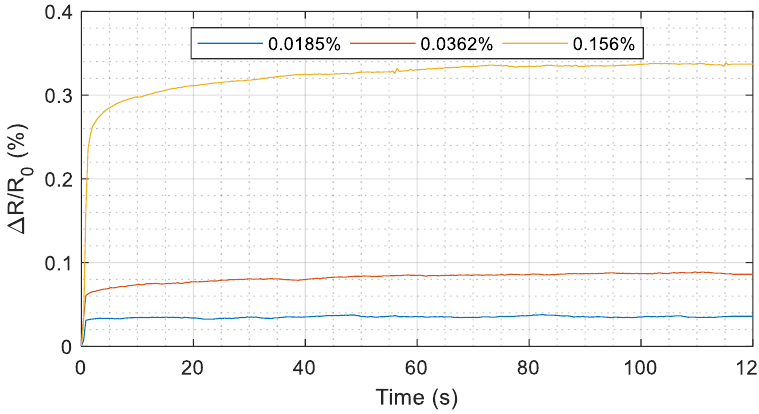
Figure 13. Resistance change with respect to the starting resistance (no external loads) over time by applying different stress levels. The corresponding strain measured at 120th second is reported in the legend for the three cases.